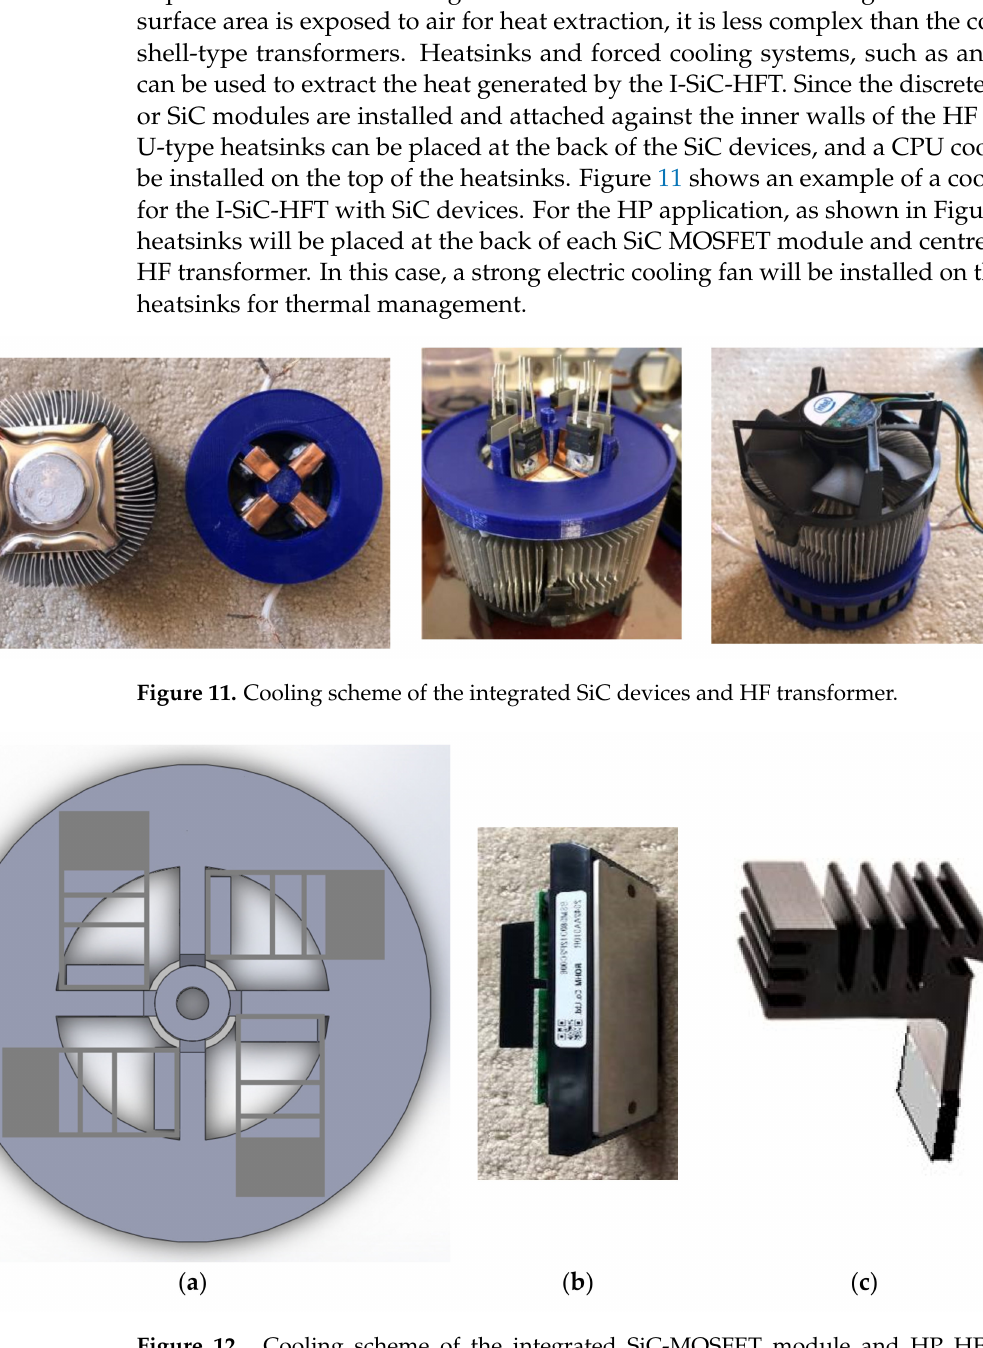
Figure 12. Cooling scheme of the integrated SiC-MOSFET module and HP HF transformer: ( a ) I-SiC-HFT; ( b ) SiC MOSFET module with gate drive; ( c ) L type heatsink attached to heatsink pad of SiC MOSFET